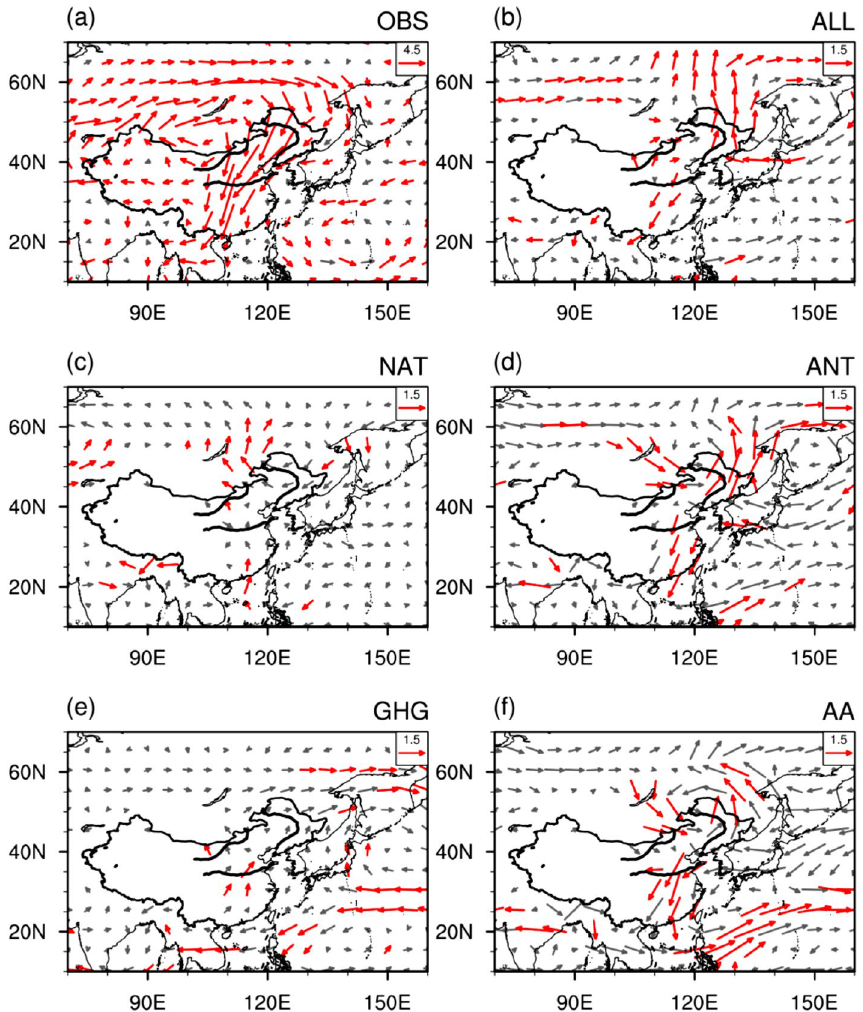
Figure 4. Linear trends of horizontal winds at 850 hPa (unit: m s −1 month −1 55 yr −1 ). Observation in ( a ) is represented by the NCEP–NCAR reanalysis 1 23 (URL: https ://psl.noaa.gov/data/gridd ed/data.ncep.reana lysis .html). The multimodel ensemble simulations of ( b ) historical run, ( c ) natural forcing run, ( d ) anthropogenic forcing run, ( e ) GHG forcing run, and ( f ) aerosol forcing run. The arrows in red represent at least one